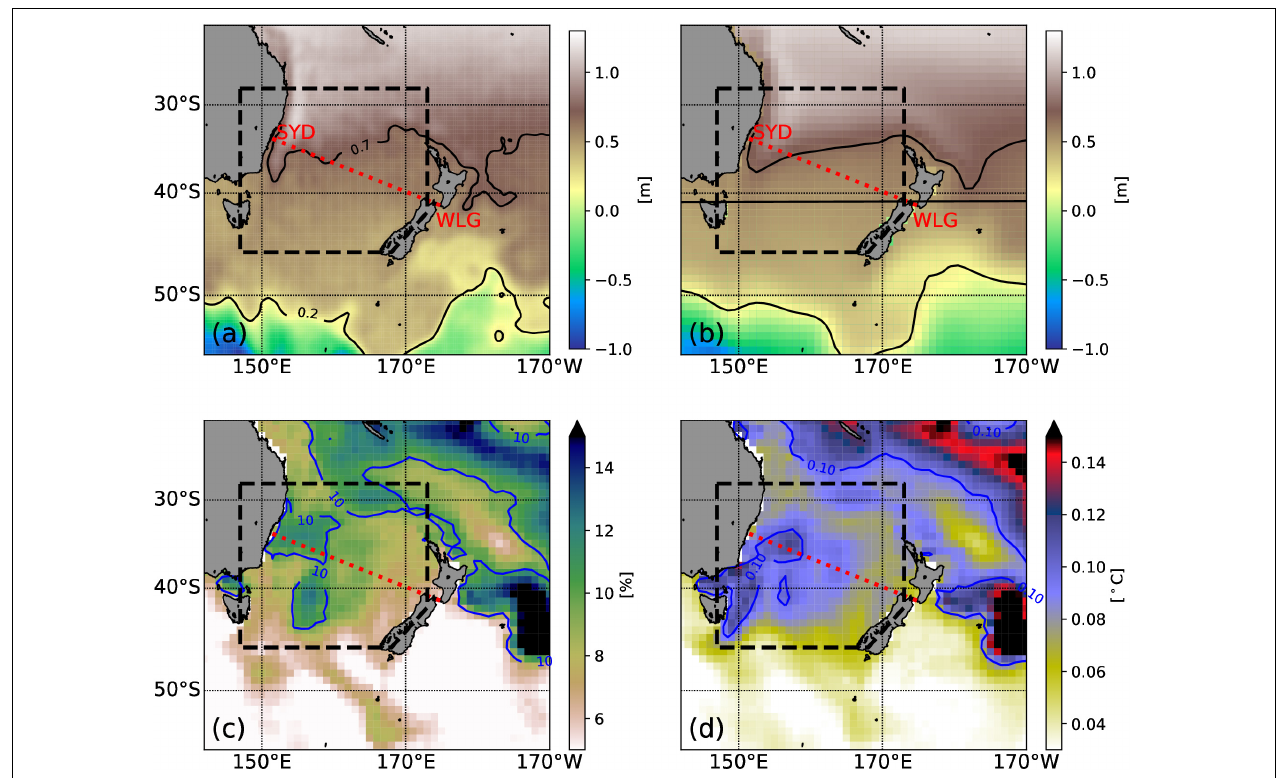
FIGURE 2 | Mean fields (1993–2017) for (a) ADT from a multi-mission altimeter product and (b) SSH from the model hindcast. Mean probability (c) of MHW and its intensity (d) for the period 1970 to 2017. The black box illustrates the Tasman Box and the dashed red line the HRXBT transect between Wellington and Sydney (PX34). The black contour lines in (a,b) represent 0.2 and 0.7 m contour lines to aid the comparison. The blue contour lines in (c,d) represent 10% and 0.1 ◦ C contours